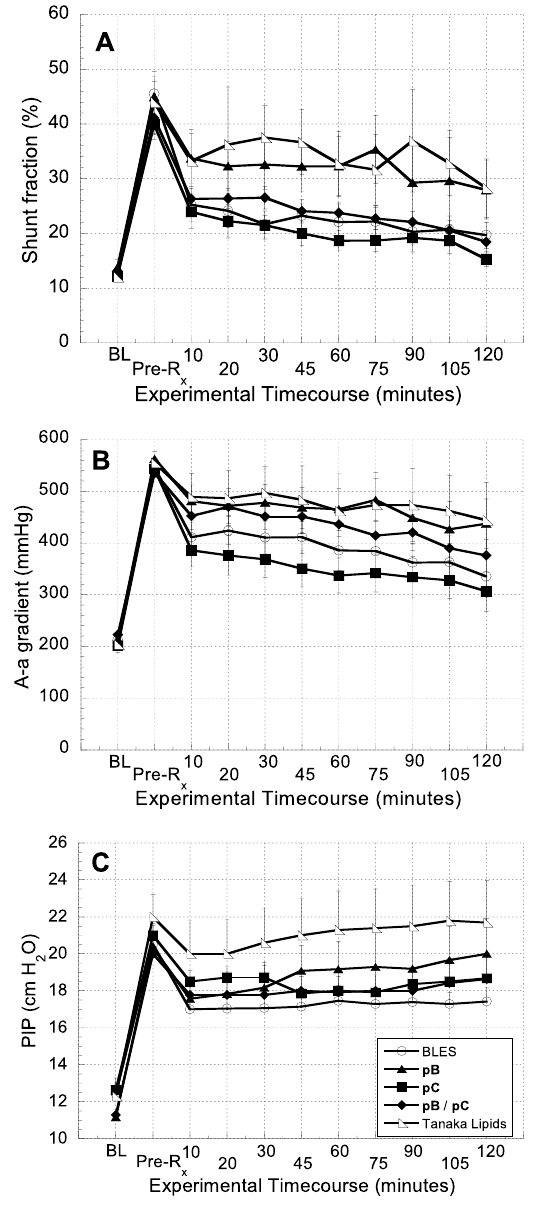
Figure 3. Physiological indicators of pulmonary function. ( A ) Shunt fraction ( B ) A-a gradient, and ( C ) Peak inspiratory pressure (PIP) over the time course of the experiments. Error bars indicate the standard error of the mean